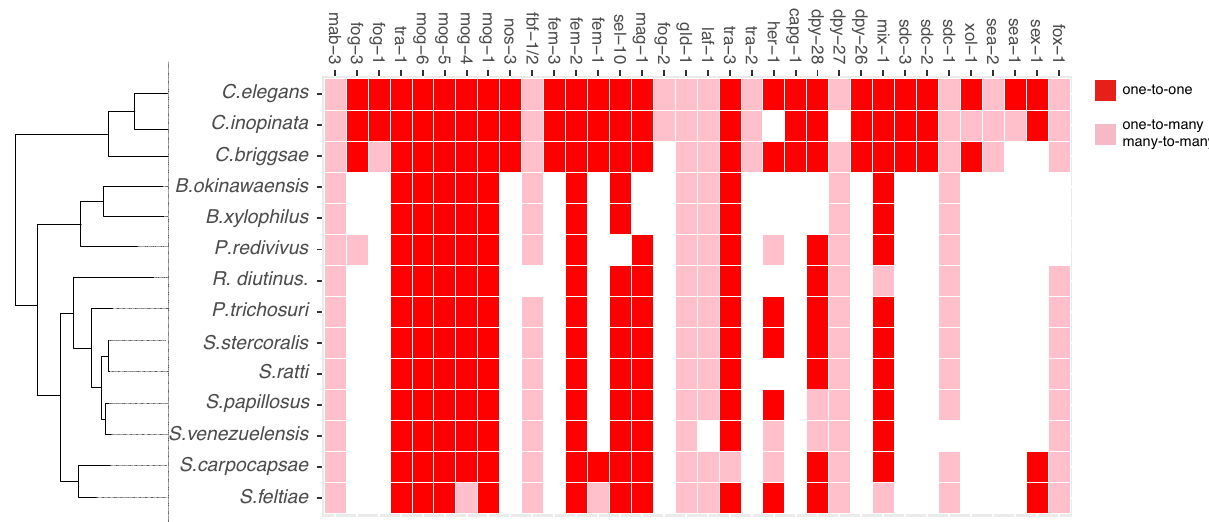
Fig. 3 Identi fi ed sex determination genes in Bursaphelenchus and other clade IV nematodes. Orthology of genes involved in the sex determination and dosage compensation in C. elegans was predicted using OrthoFinder for B. xylophilus , B. okinawaensis , and two Caenorhabditis species ( Caenorhabditis inopinata and Caenorhabditis briggsae ) and clade IV nematodes ( Panagrellus redivivus , Rhabditophanes sp. KR3021, Parastrongyloides trichosuri , Strongyloides papillosus , Strongyloides ratti , Strongyloides stercoralis , Strongyloides venezuelensis , Steinernema carpocapsae, and Steinernema feltiae